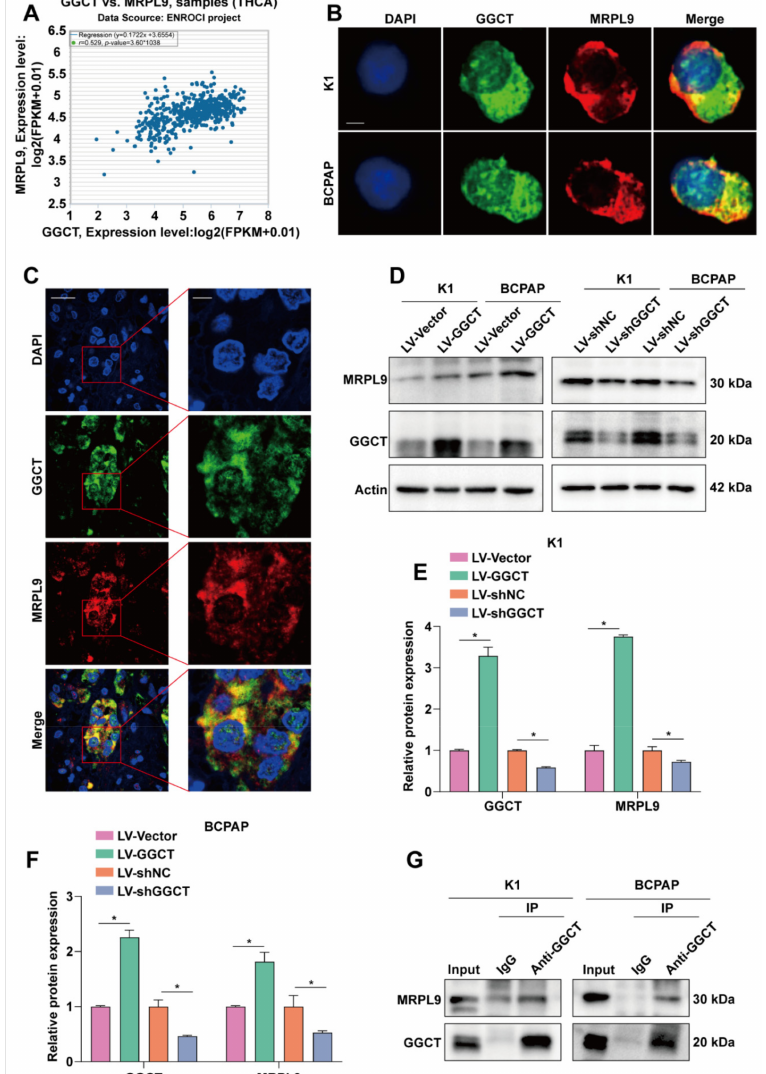
Figure 3. Interaction between GGCT and MRPL9. ( A ) The Starbase database (http://starbase.sysu. edu.cn/index.php, accessed on 22 March 2022) analyzed the correlation between GGCT and MRPL9 in thyroid cancer. ( B ) Immunofluorescence assays explored the localization of MRPL9 and GGCT in cells (scar bar = 5 µ m). ( C ) Representative image of the localization of MRPL9 and GGCT detected by immunofluorescence homologous double labeling experiments on paraffin sections (Left figure, scar bar = 20 µ m; Right figure, scar bar = 5 µ m). ( D ) GGCT was overexpressed/knocked down in K1/BCPAP cells, and the protein expression level of MRPL9 was detected by Western blot. ( E ) The expression levels of GGCT and MRPL9 in the K1 cell line were analyzed with image J, and normalized to Actin ( n = 3). ( F ) The expression levels of GGCT and MRPL9 in the BCPAP cell line were analyzed with image J, and normalized to Actin ( n = 3). ( G ) The interaction between GGCT and MRPL9 was analyzed by Co-IP in K1/BCPAP cells. Measurement data (mean ± standard deviation) between two groups were compared by paired t test. “*” represents p ≤